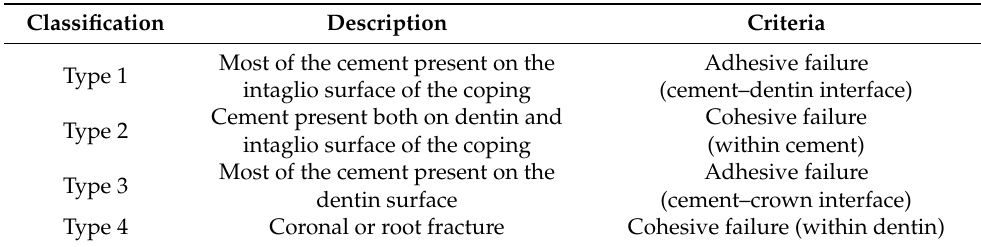
Figure 4. Example of the de-bonded surfaces inspected for failure and its type under 20× magnification (Scanning Electron Microscope, Hitachi High-Tech, HHT, Tokyo, Japan). ( A ). Image of the dentin surface, ( B ). Image of the intaglio surface of the coping. Table 3. Failure classification criteria.